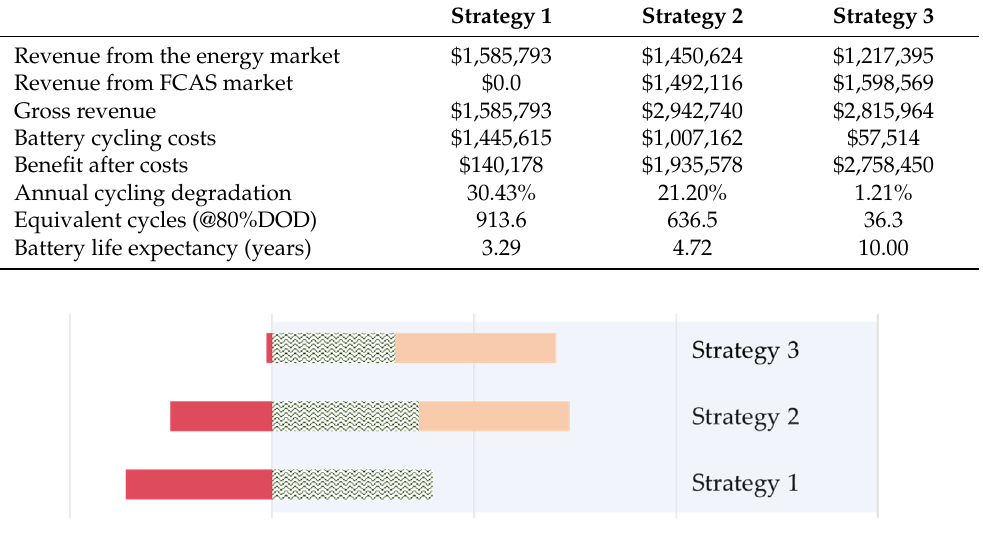
Table 5. Outcomes from dispatch of 12.5 MWh BESS participating in Australian energy market